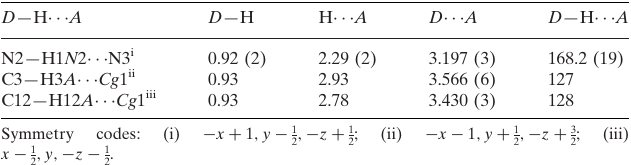
Hydrogen-bond geometry (A˚ , (cid:2) ). Cg 1 is the centroid of the major disorder component of the thiophene